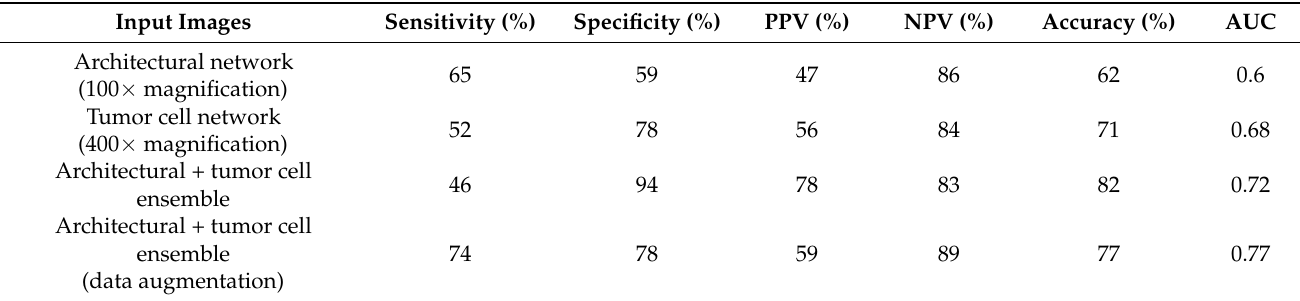
Table 1. Performance evaluation of cohort I (average of five-fold cross-validation, n = 302).